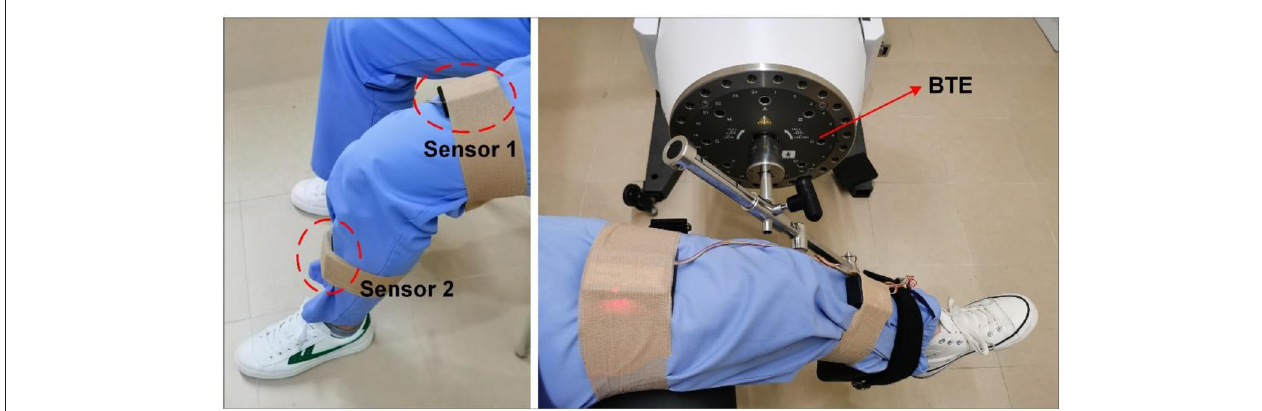
FIGURE 2 | Inertial measurement units and BTE rehabilitation equipment.